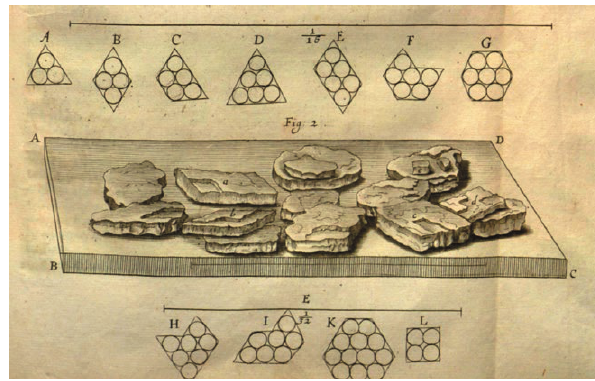
Fig. 5. Hooke’s reconstruction of alum crystals by close packing of identical spheres. After Hooke, 1665 [9] (https://authors.library.